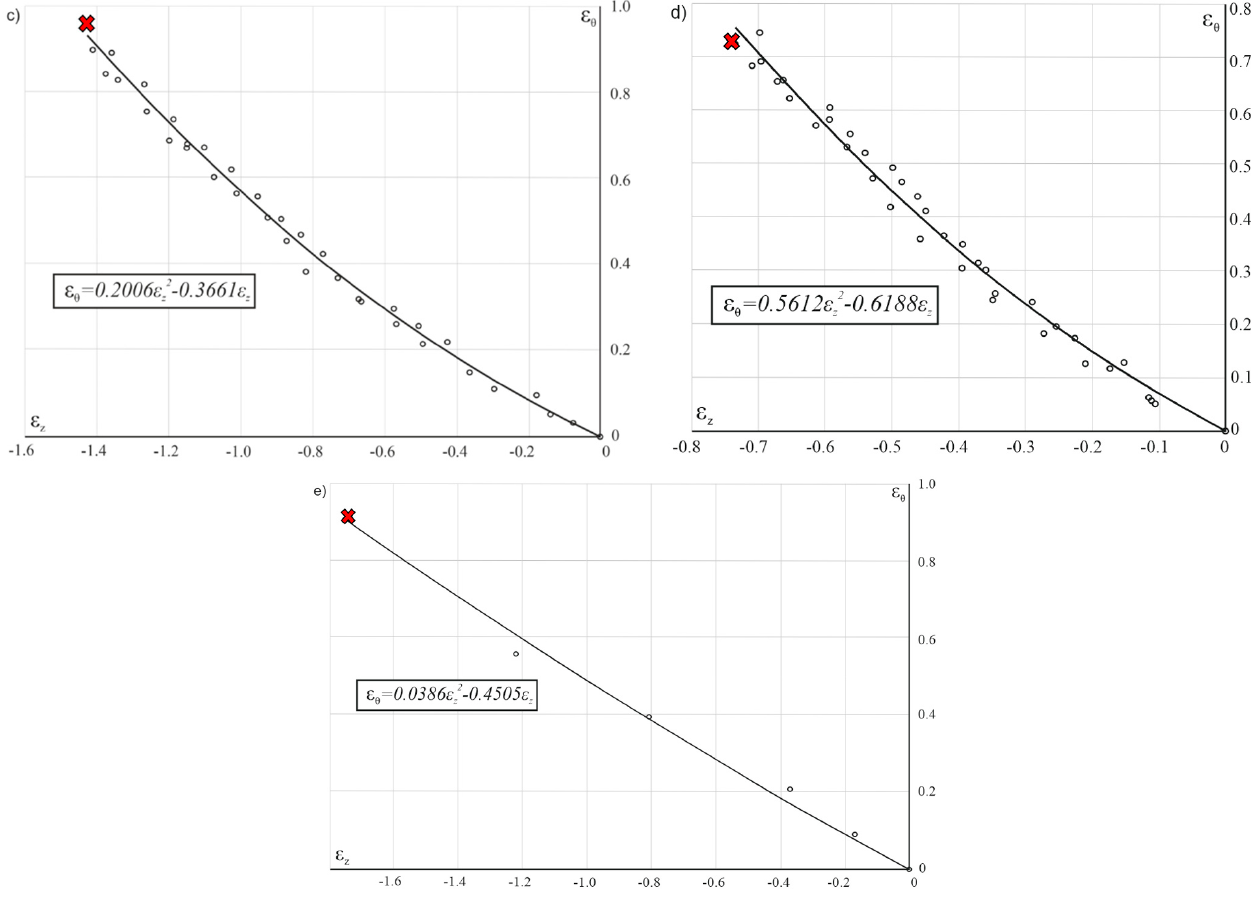
Figure 4. Strain paths at the site of fracture initiation: ( a )—series 1, ( b )—series 2, ( c )—series 3, ( d )—series 4, ( e )—series 5. Table 3. Circumferential and axial strains at the instant of fracture initiation.